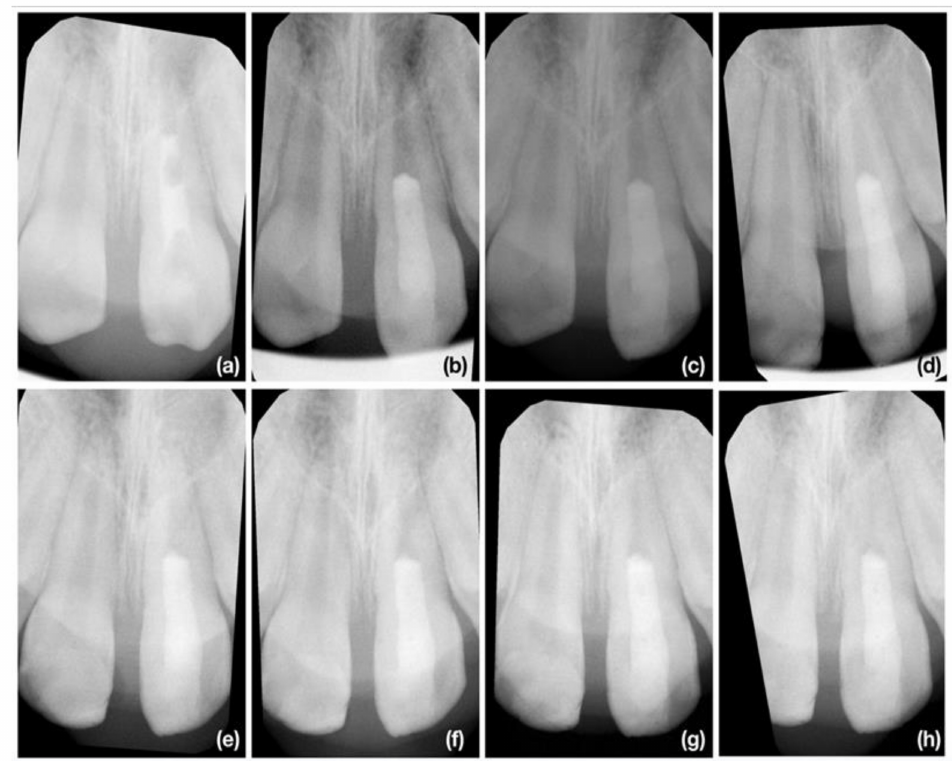
Figure 6. The illustrative case of the most successful courses after regenerative endodontic procedure (REP). The 8-year-old girl was referred for endodontic treatment 2 months after dental traumatic injury of tooth 21 (non-complicated crown fracture). ( a ) The diagnostic X-ray of tooth 11 and 21. There is presence of periapical radiolucency of tooth 21; ( b ) The X-ray taken immediately after finishing REP; ( c ) The control X-ray at 3-months follow up. The periapical lesion of tooth 21 was healed. There are no evident signs of newly produced mineralized tissue; ( d ) The control X-ray at 6-months follow up. There are signs of increase in root canal wall thickness along whole root up to coronal barrier; ( e ) The control X-ray at 9-months follow up; ( f ) The control X-ray at 12-months follow up; ( g ) The control X-ray at 18-months follow up; ( h ) The control X-ray at 24-months follow up. Progressive obliteration of root canal system is evident. There is present radiolucency under coronal